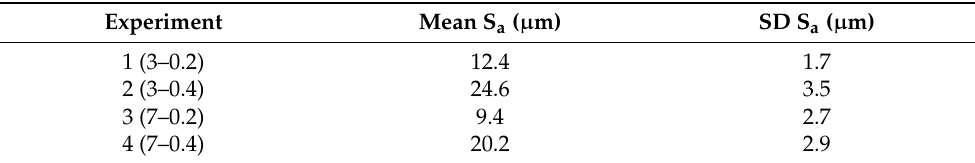
Table 2. Mean and standard deviation (SD) of areal average roughness S a of the printed samples. Experiment